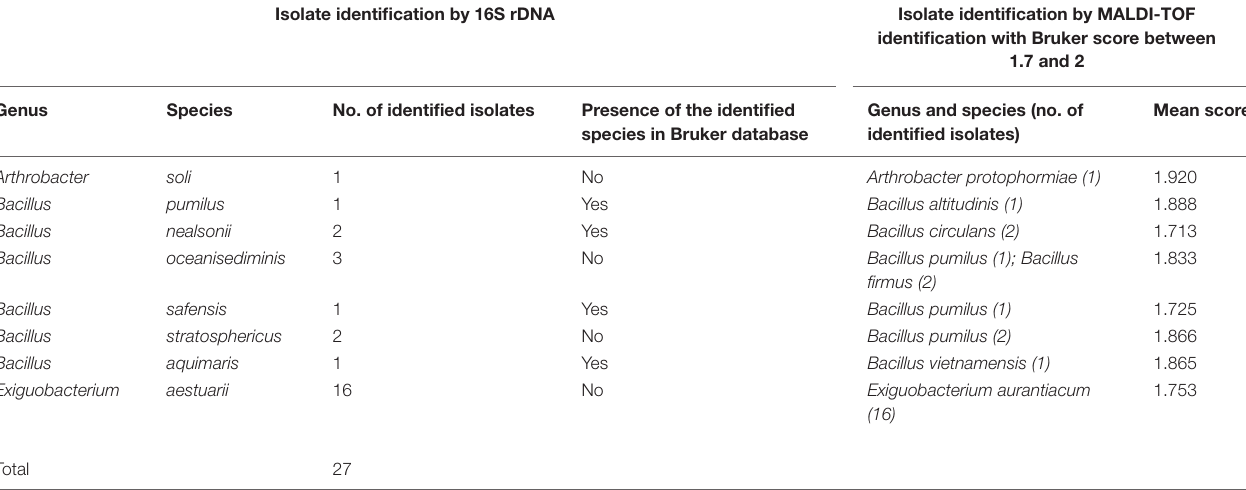
TABLE 3 | Non-conformity of strain identification in 16S rDNA technique and MALDI-TOF method. Isolate identification by 16S rDNA Isolate identification by MALDI-TOF identification with Bruker score